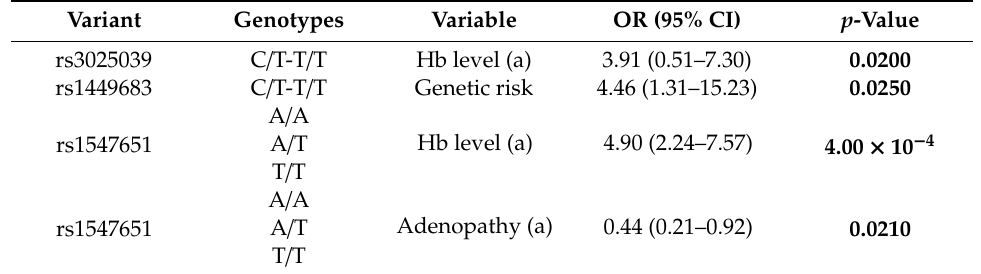
Table 5. Association of VEGFA and bFGF genotypes in B-CLL patients with significant risk factors.